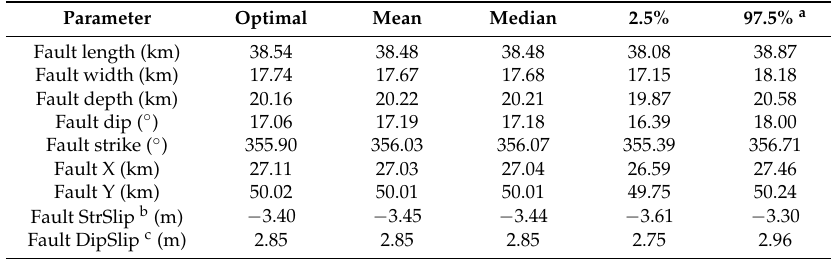
Table 3. Inversion results for the Iran earthquake.